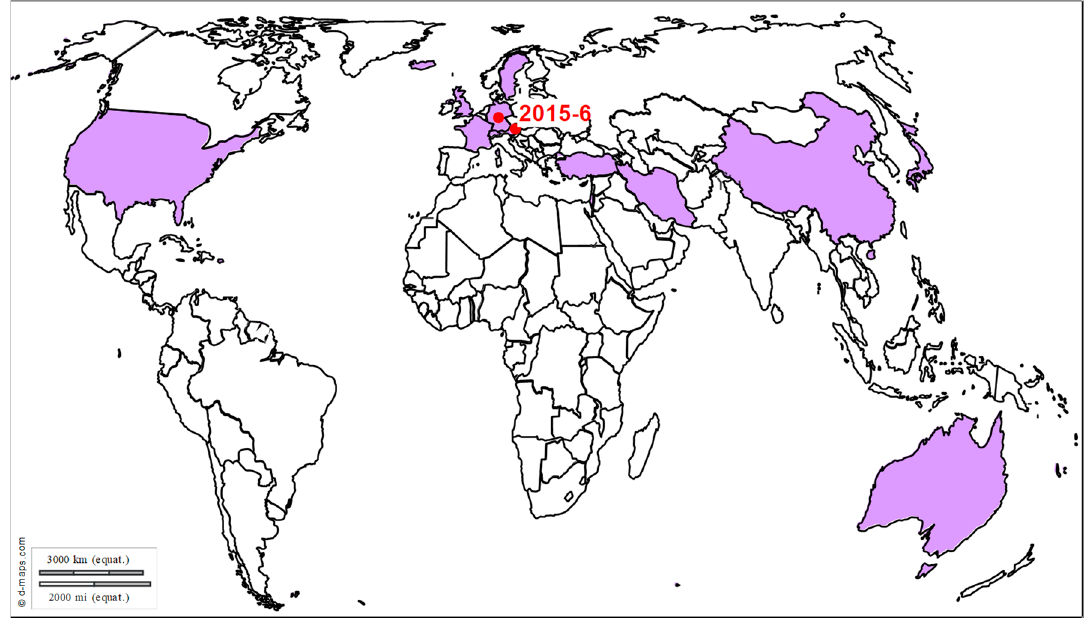
Figure 6. Distribution of Borna disease outbreaks. Recent outbreaks in horses reported to Promed Alerts [16] or in the scientific literature are depicted by dots